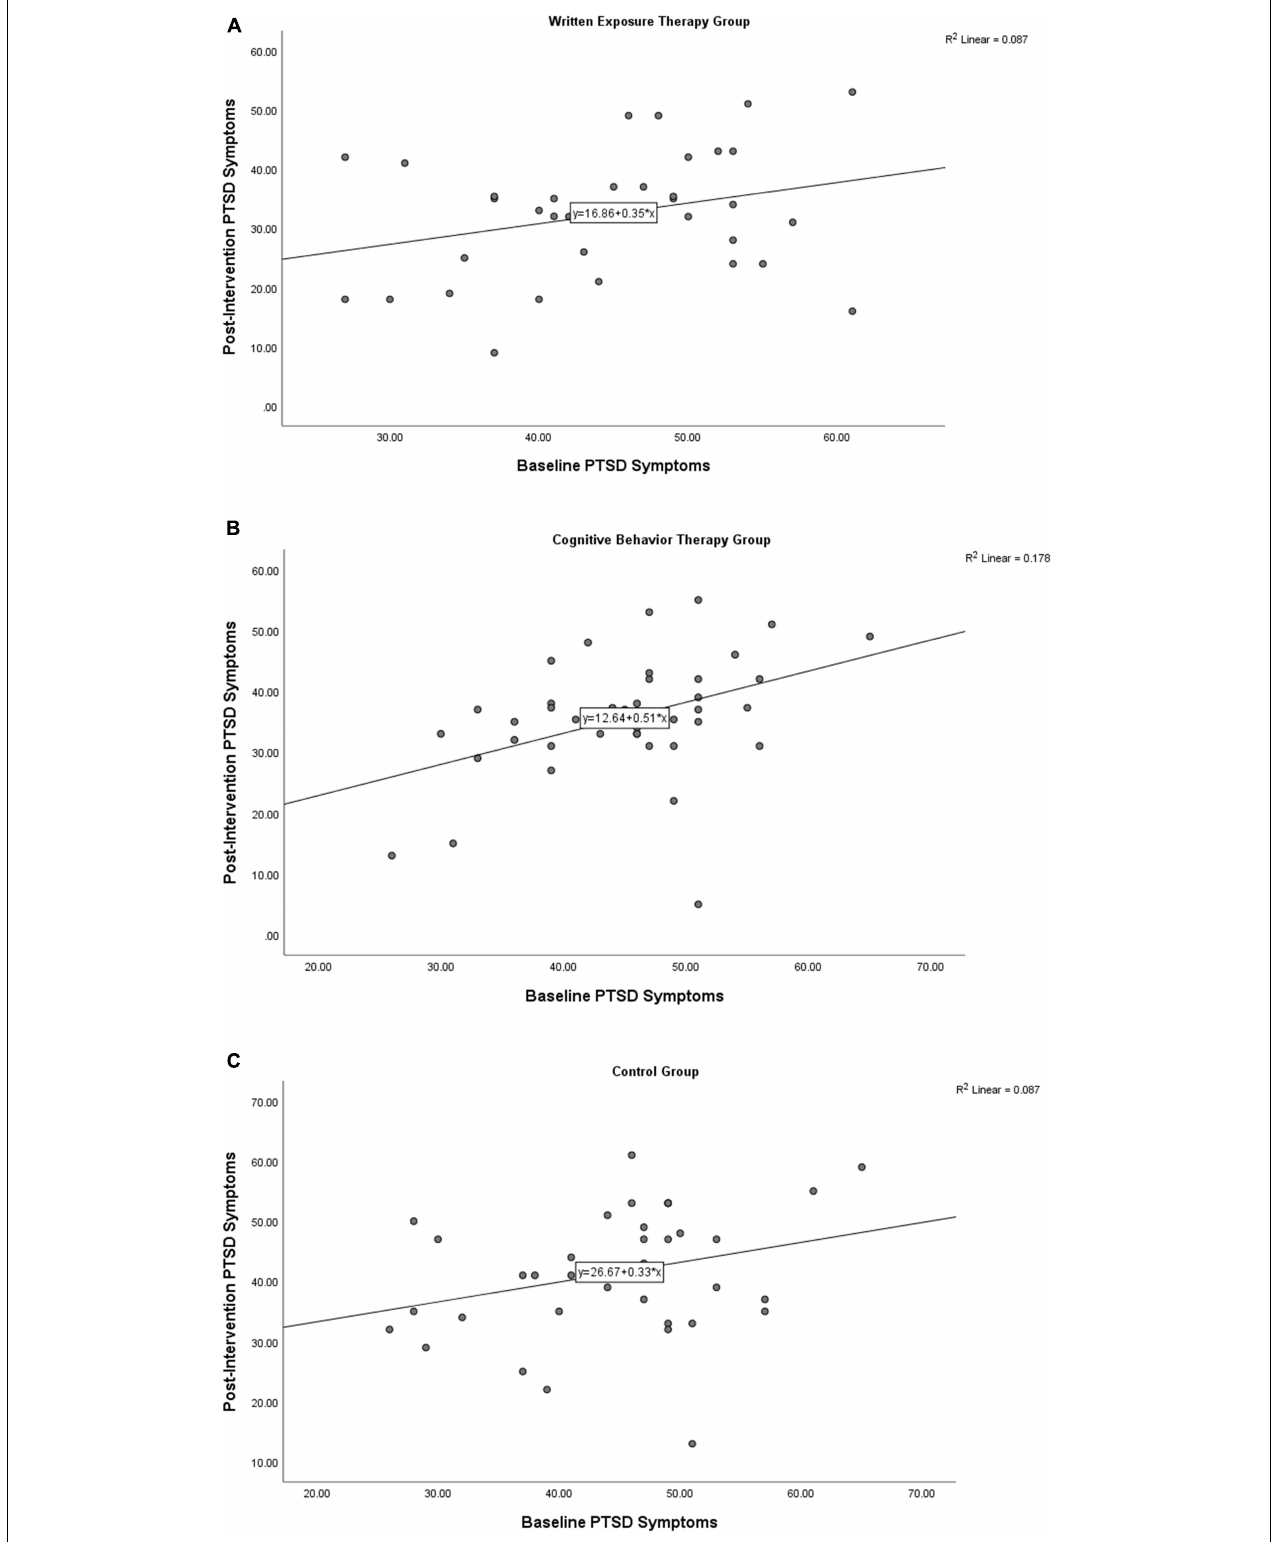
FIGURE 2 | Scatterplots for the Baseline and Post-Intervention Posttraumatic Stress Disorder (PTSD) symptoms for the written exposure group (A) , cognitive behavior therapy group (B) and control group (C) .